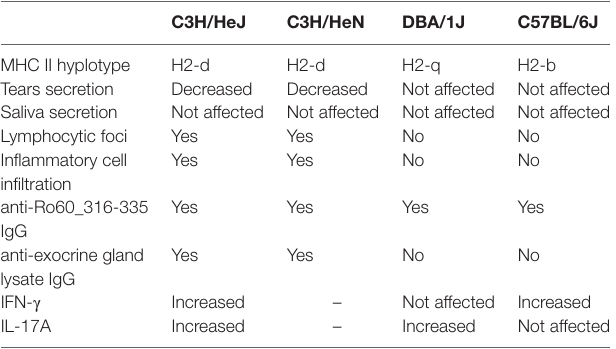
TaBle 1 | Summary of the development of the Ro60_316-335 induced primary Sjögren’s syndrome -like disease among mouse strains. c3h/heJ